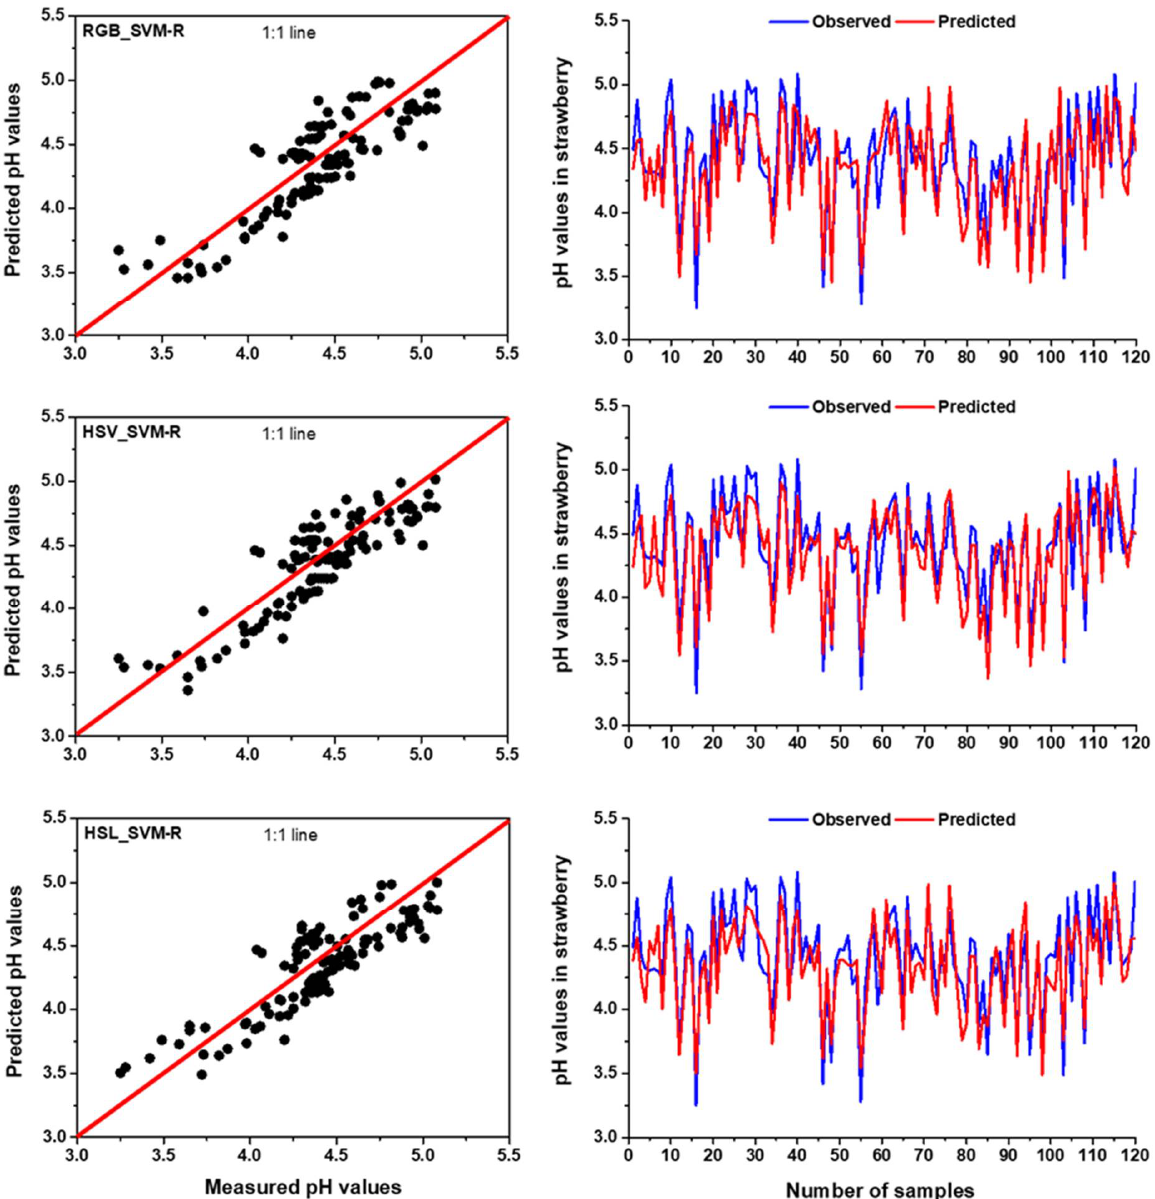
Figure 9. The comparison results between measured and predicted values by SVM-R model with RGB, HSV and HSL colour spaces for pH prediction in the testing period using time series and scatter plots with 1:1 line.